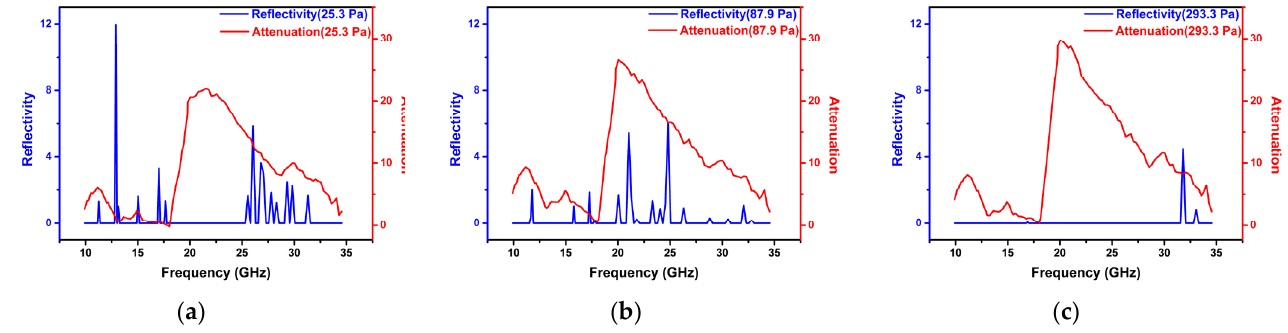
Figure 6. Graph of reflectivity and attenuation measurement results according to pressure variation; ( a ) 25.3 Pa results, ( b ) 87.9 Pa results, ( c ) 293.3 Pa results.